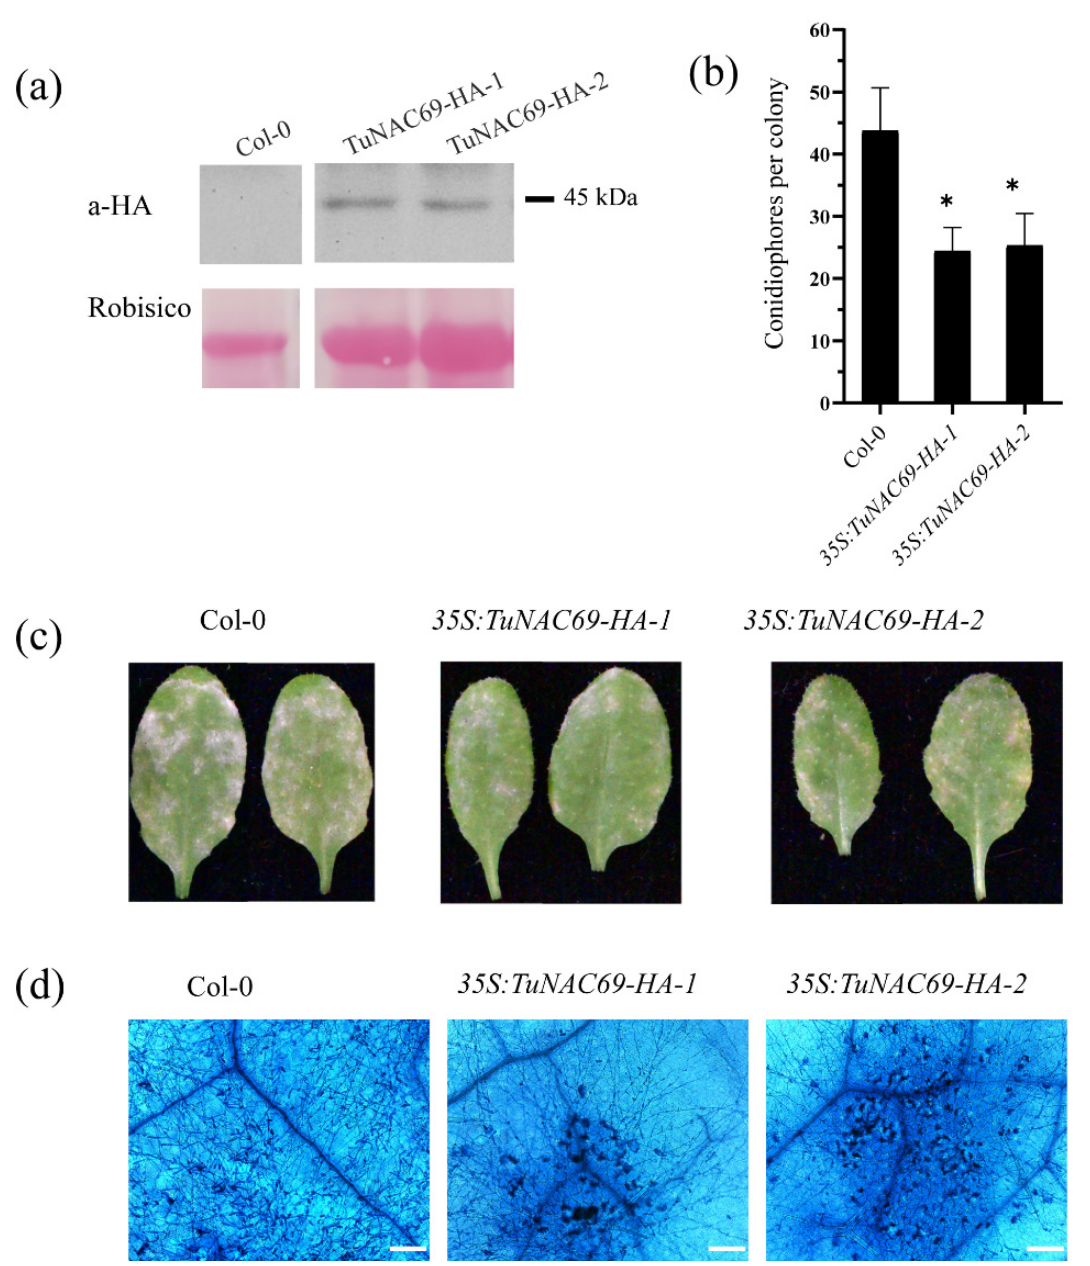
Figure 8. The TuNAC69-overexpressing Arabidopsis exhibits increased resistance to G. cichoracearum. ( a ) Accumulation of TuNAC69 protein was examined by immunoblot analysis in the transgenic Arabidopsis . ( b ) Quantitative analysis of conidiophore formation in Col-0, 35S:TuNAC69-HA-1 and 35S:TuNAC69-HA-2 plants at 5 dpi. Error bars represent ± SD from three independent experiments ( n > 30). Statistically significant difference (Student’s t -test): *, p < 0.05. ( c ) Four-week-old plants were infected with G. cichoracearum and the representative leaves were photographed at 7 dpi. ( d ) Trypan blue staining of leaves after infection with G. cichoracearum at 7 dpi (Bar = 200 µ m).